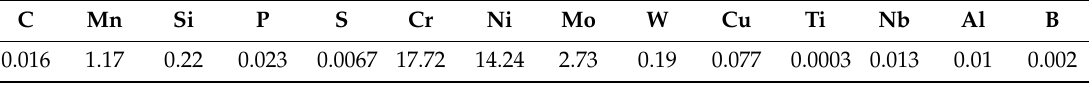
Table 1. Chemical composition of AISI316L base material in